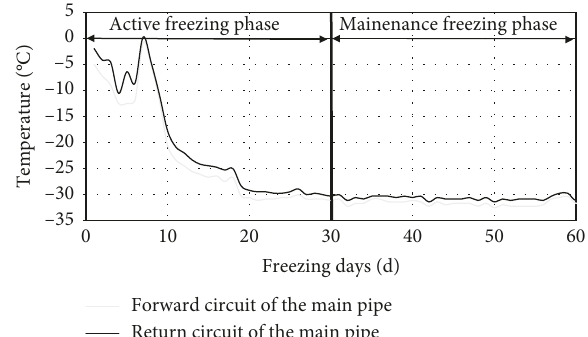
Figure 6: Temperature variation curves of saline solution in the main pipe